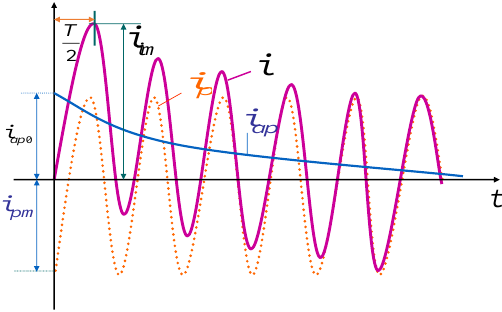
Figure 6. The composition of a three-phase short-circuit fault.